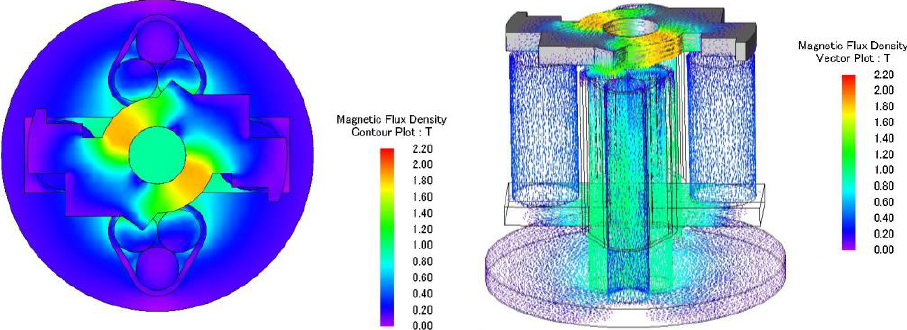
Figure 11. Top view and 3D view of magnetic flux density plots of the motor at a rotating angle of 0°.